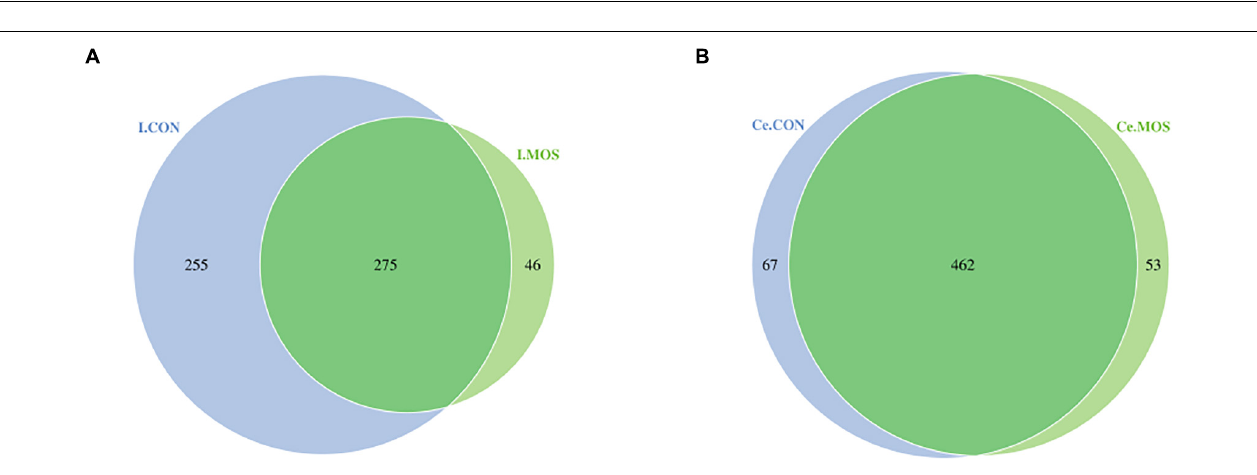
Frontiers in Microbiology |